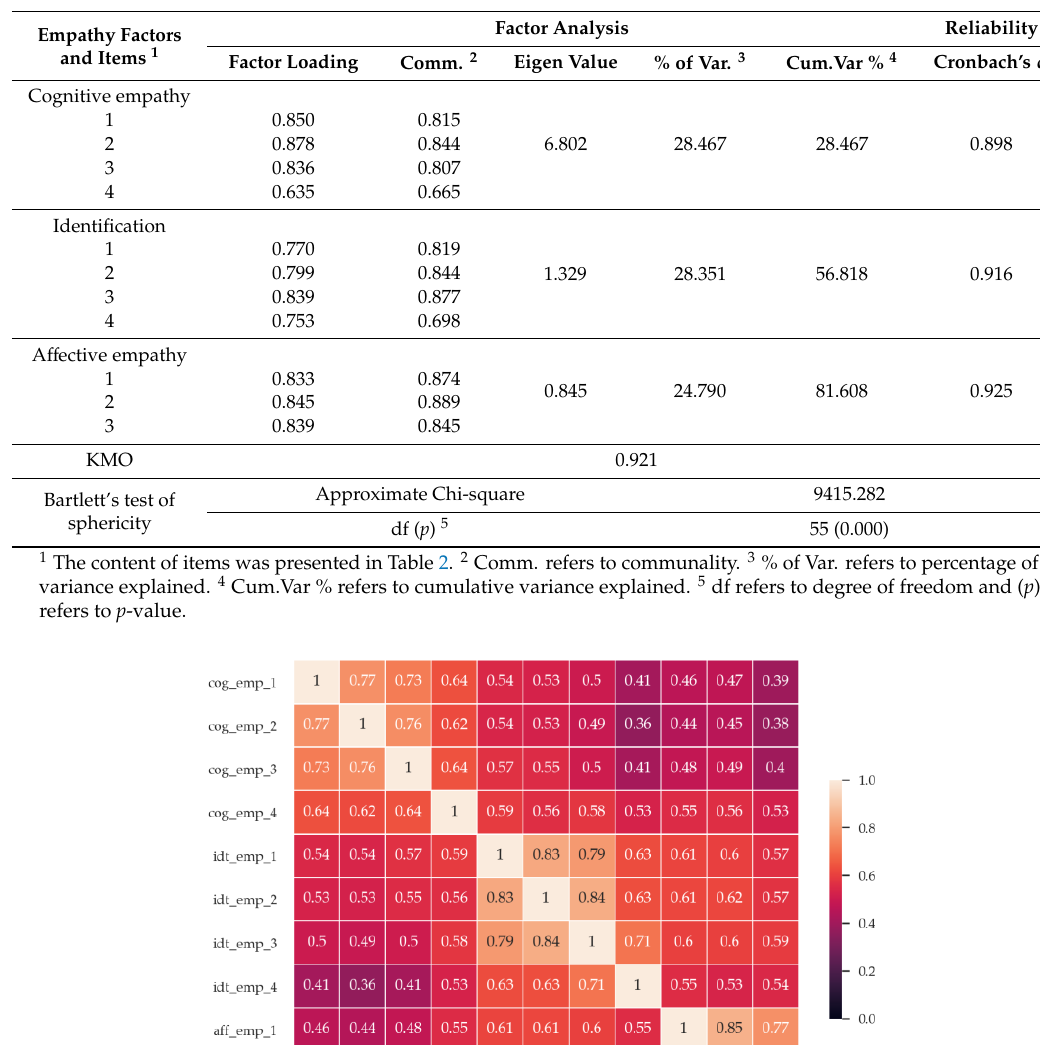
Table 3. Verification of the CERA scale using responses of 198 pre-test participants.